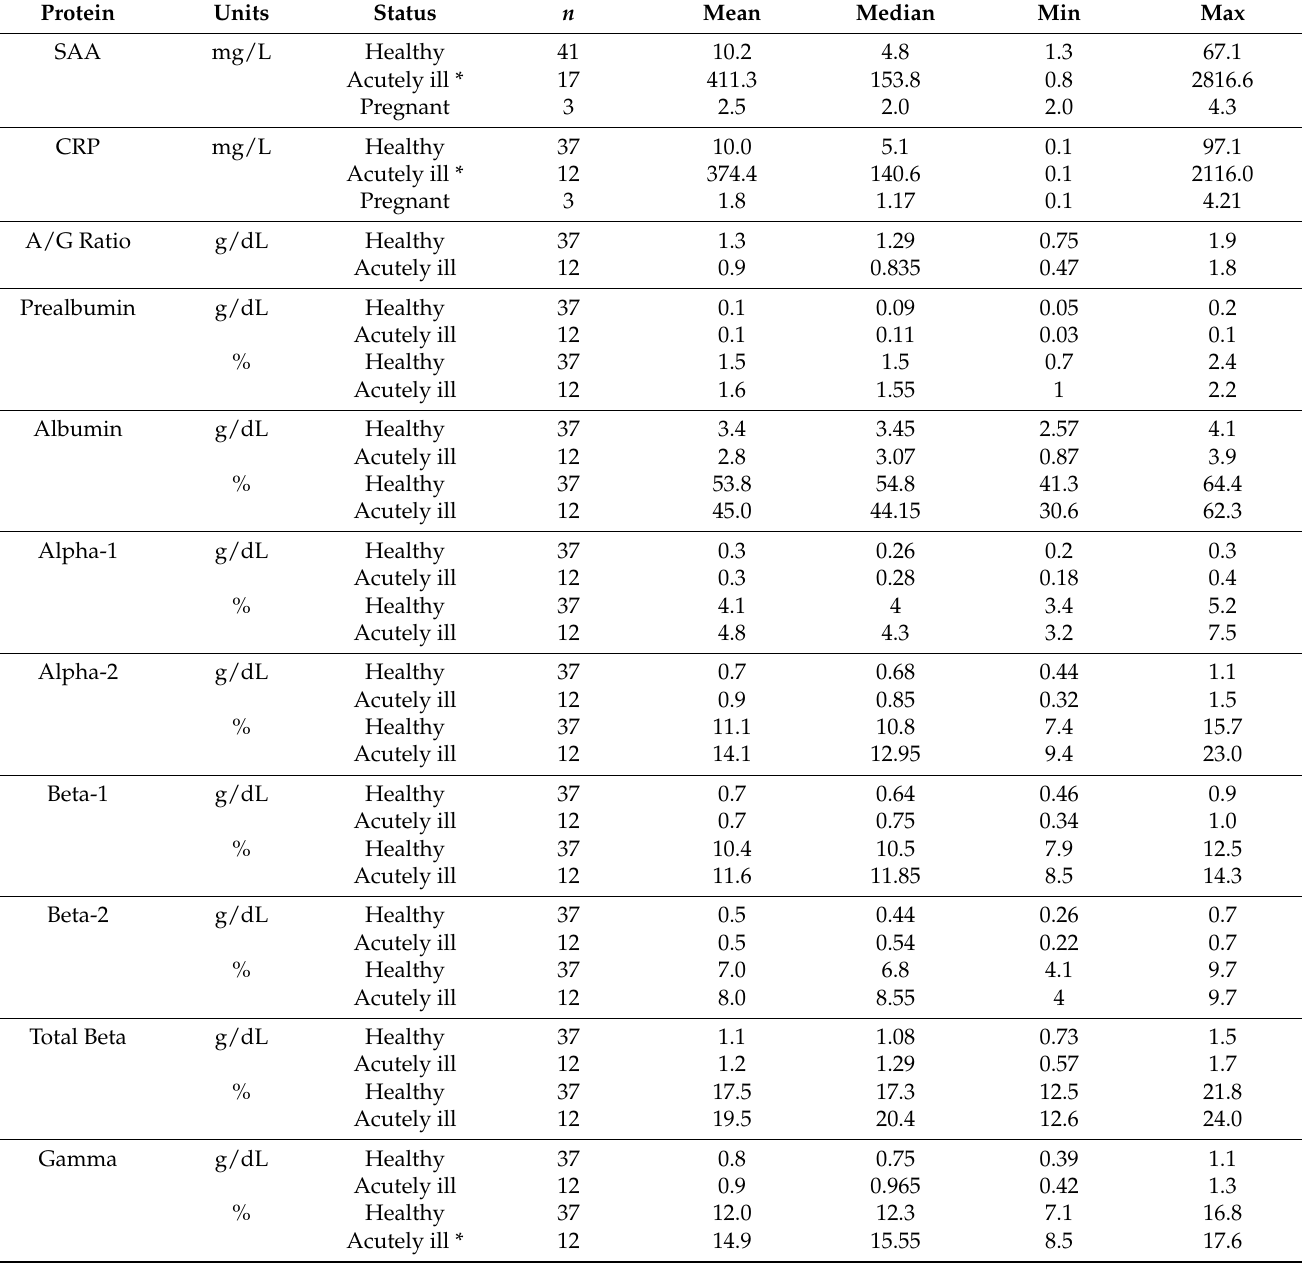
Table 1. Descriptive statistics for serum amyloid A (SAA), C-reactive protein (CRP), and protein electrophoresis fractions in hamadryas baboons of various health status. The healthy and acutely ill cohorts include males, females, and all age groups. An asterisk indicates statistical significance compared to the healthy cohort, p ≤